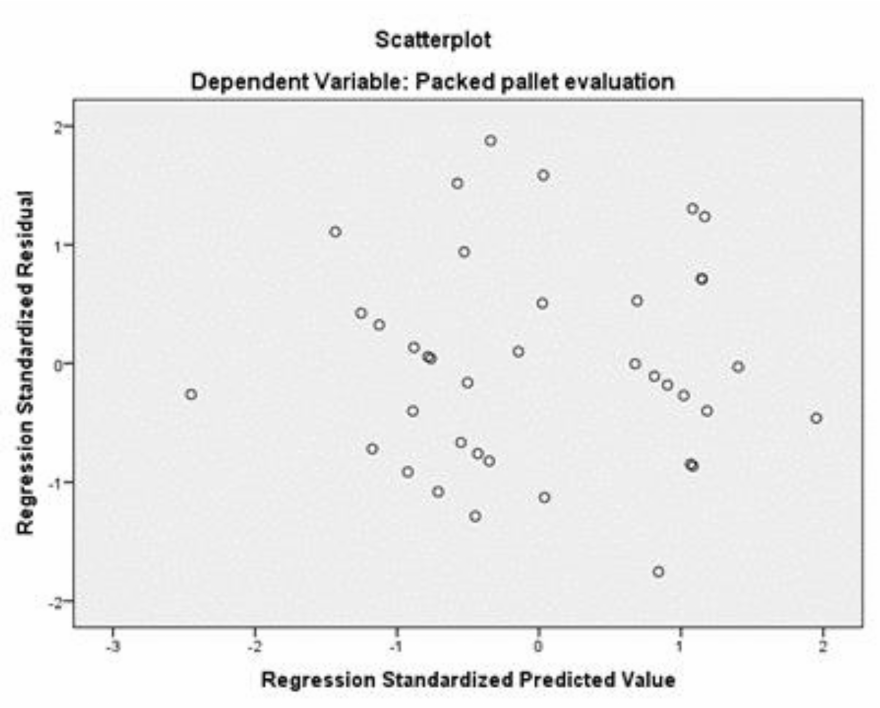
Figure 4. Scatterplot to test residuals homogeneity (for 9